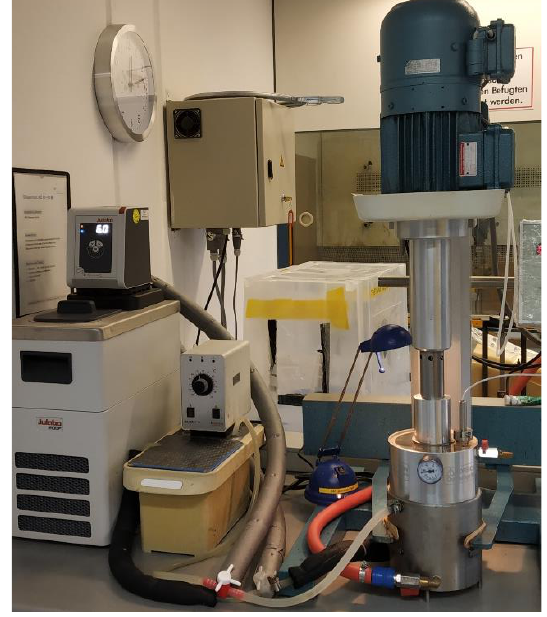
Figure 1. Dissolver machine.